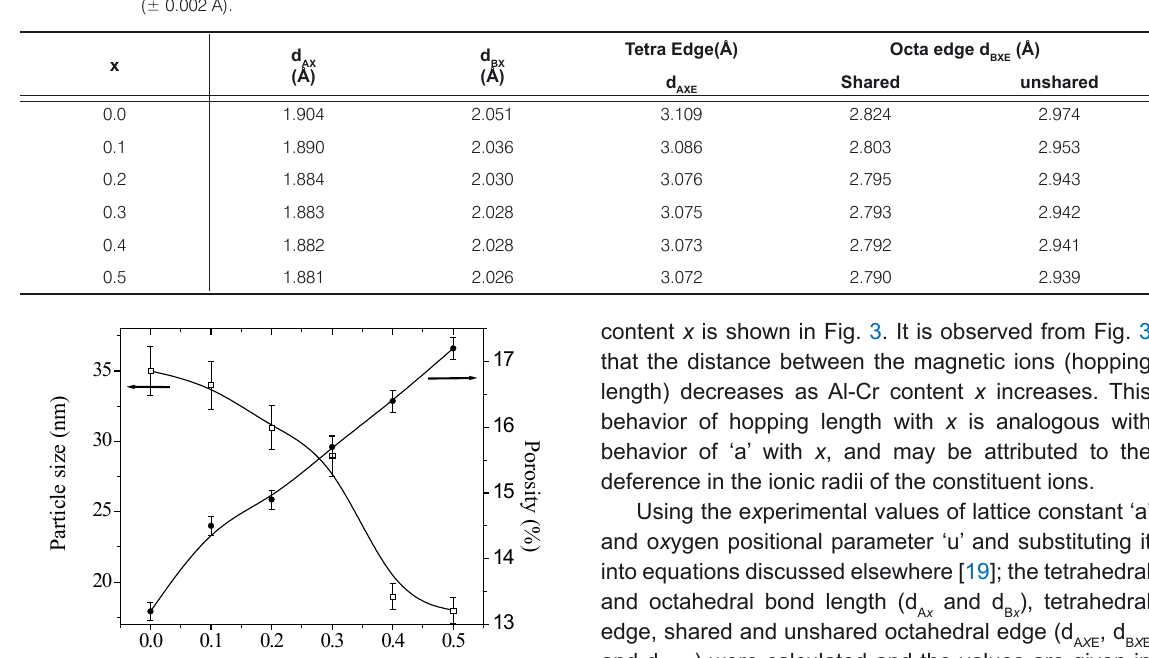
), Octahedral bond (d Ax